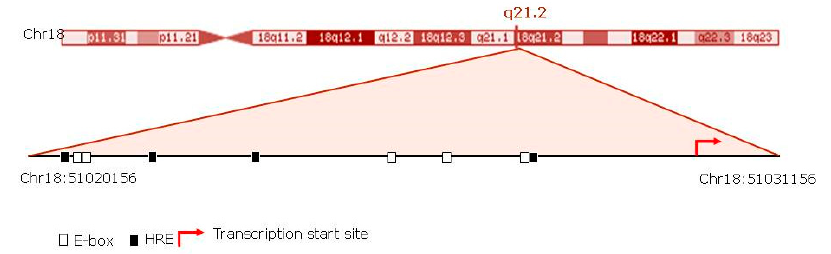
Figure 5. Schematic representation of the in silico analysis of the potential E-BOX and HRE binding sites, in the SMAD4 promoter sequence (Ensembl reference sequence ENS), based on the consensus sequence. Location of these E-BOX and HREs are shown. Data obtained from TRANSFAC ® database. Table 2. Position, matrix score, core score and sequence from the EBOX and HRE motifs.